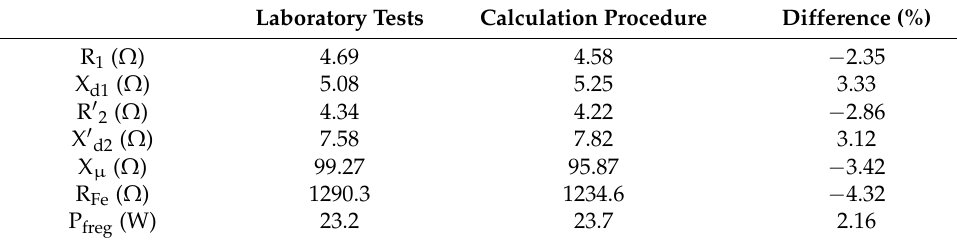
Table A2. Equivalent circuit parameters: comparison results on the 1.5 kW